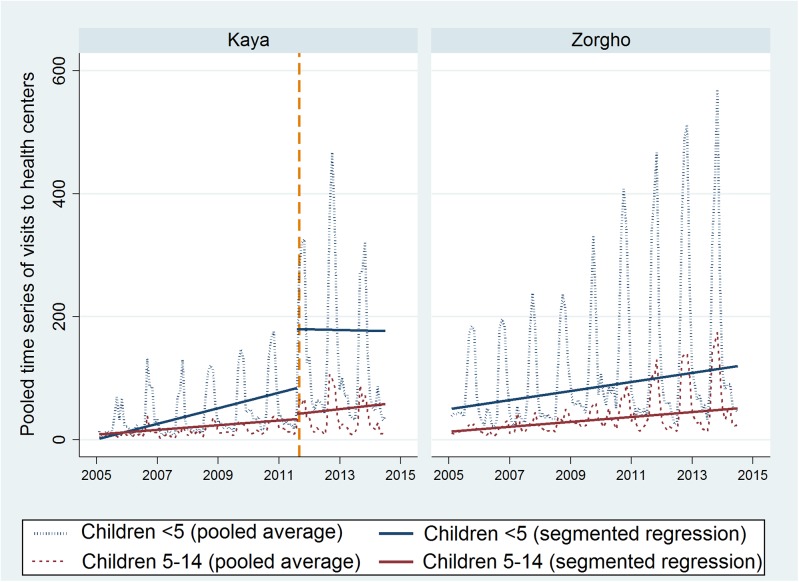
Average number of visits to Health Centers by month (children <14 years with a diagnosis of malaria).